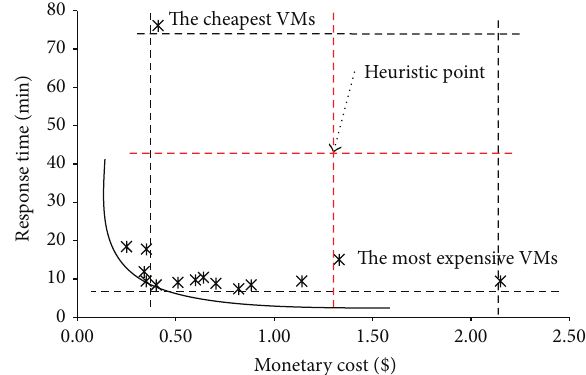
Figure 4: Proposed heuristic value for MOBB